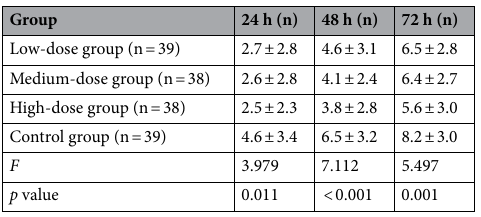
Table 5. The number of exclusive breastfeeding sessions of 3 days (n).